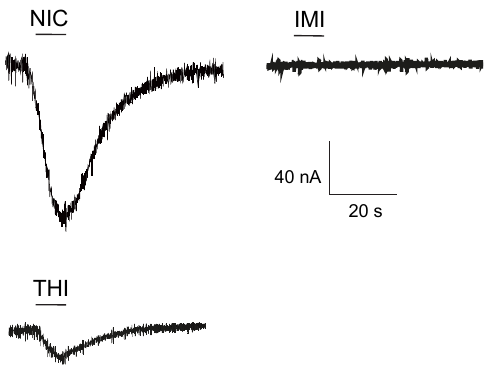
Figure 2. Currents induced by nicotine (NIC), imidacloprid (IMI) and thiacloprid (THI) on Pame α 7 homomeric receptors expressed on Xenopus laevis oocytes.